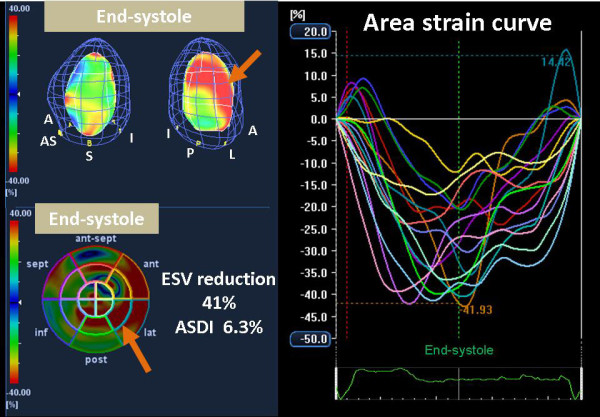
Color-coded 3-D LV display (top left) and bull's-eye plot image (bottom left) and corresponding area strain curves from 16 LV sites (right) for a responder, demonstrating dyssynchronous strain curves represented by heterogeneous coloring at end-systole, with delayed peak strain in lateral segments (orange arrow). A and ant = anterior; AS and ant-sept = anterior-septum; I and inf = inferior; L and lat = lateral; P and post = posterior; S and sept = septal.